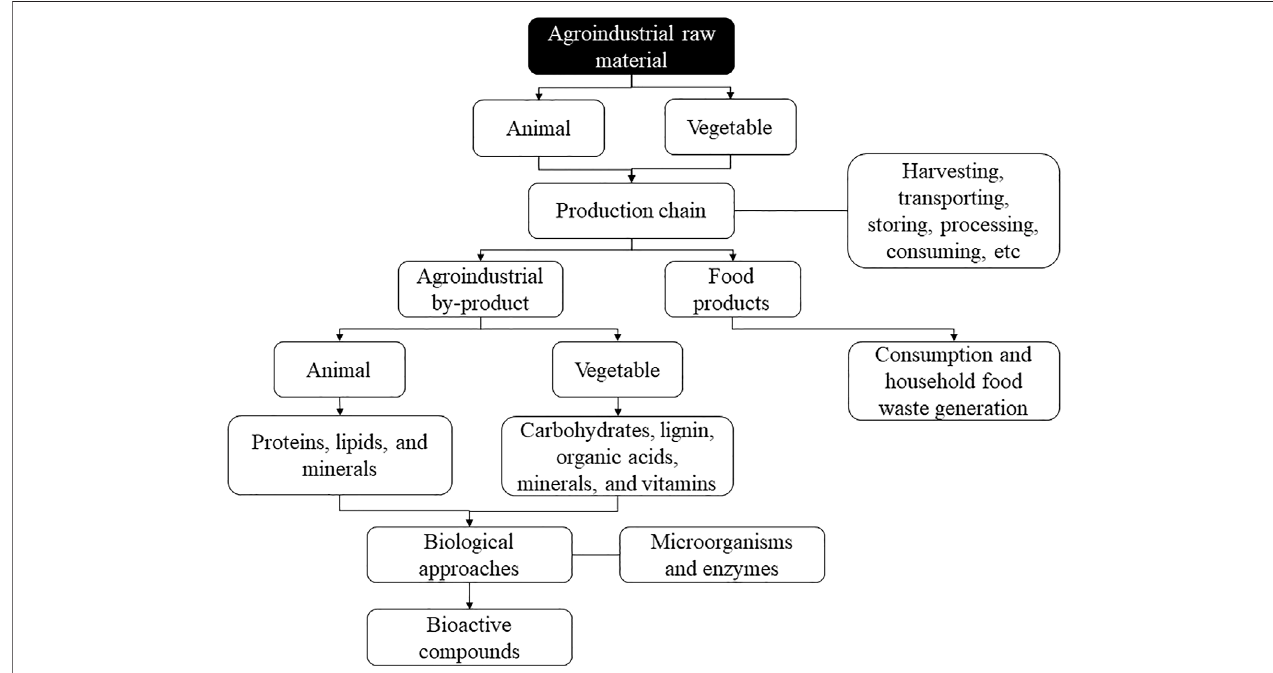
FIGURE 1 | General steps that involve the generation of agroindustrial wastes and their use to produce bioactive components.